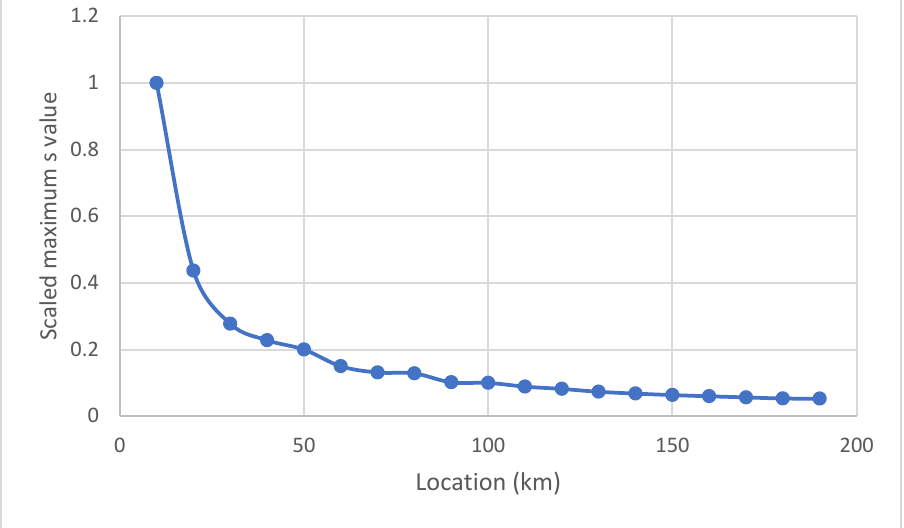
Figure 7. The best fitting curve at 19 fault locations for LL fault using scaled maximum singular value. Table 5. Actual (A in km) and predicted (P in km) fault locations under LG fault